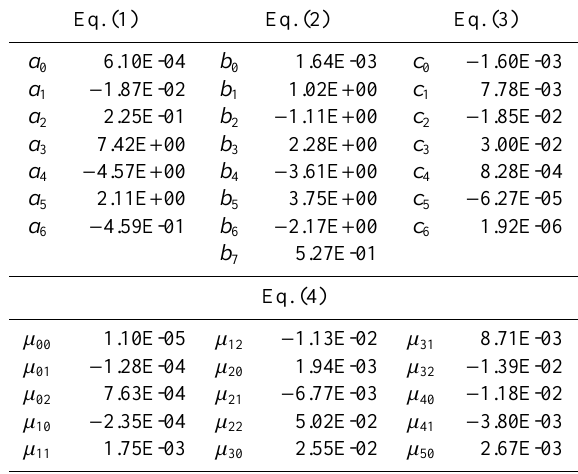
Figure 11. Fitting errors.